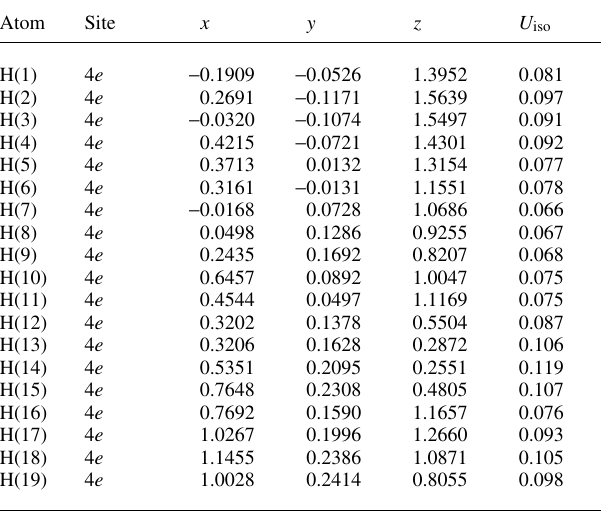
Table 2. Atomic coordinates and displacement parameters (in Å 2 )